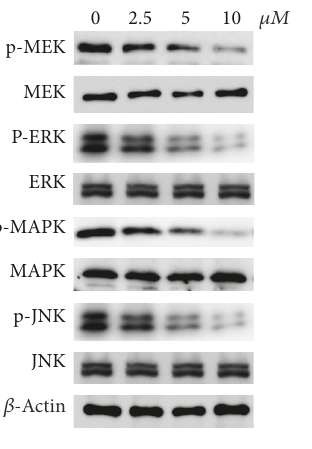
Figure 5: Aloesin inhibits the phosphorylated levels of MAPK signaling pathway. Western blot analysis of the protein levels of MAPK family members in SKOV3 cells with distinct doses of aloesin treatment. Both the total level and phosphorylated level of each member were detected. β -actin was developed as a loading